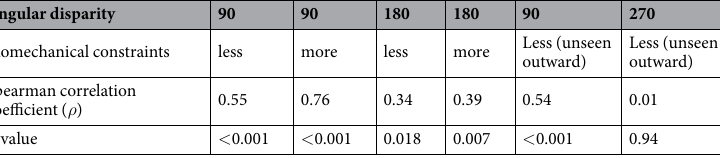
Table 1. Correlation between ownership ratings and postural displacement percentage in Experiment